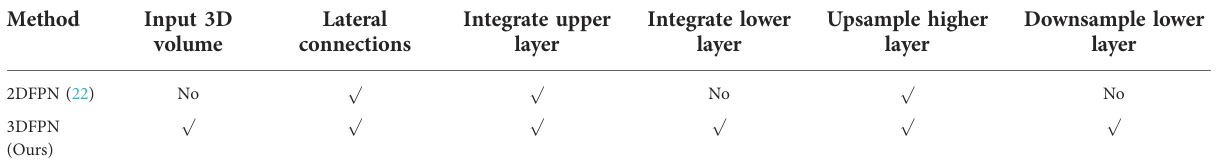
TABLE 1 Comparison between 2DFPN (22) and our proposed 3DFPN . With the 3D input of the proposed network, the feature pyramid layers are parallel connected with all the high and low-level features. Method